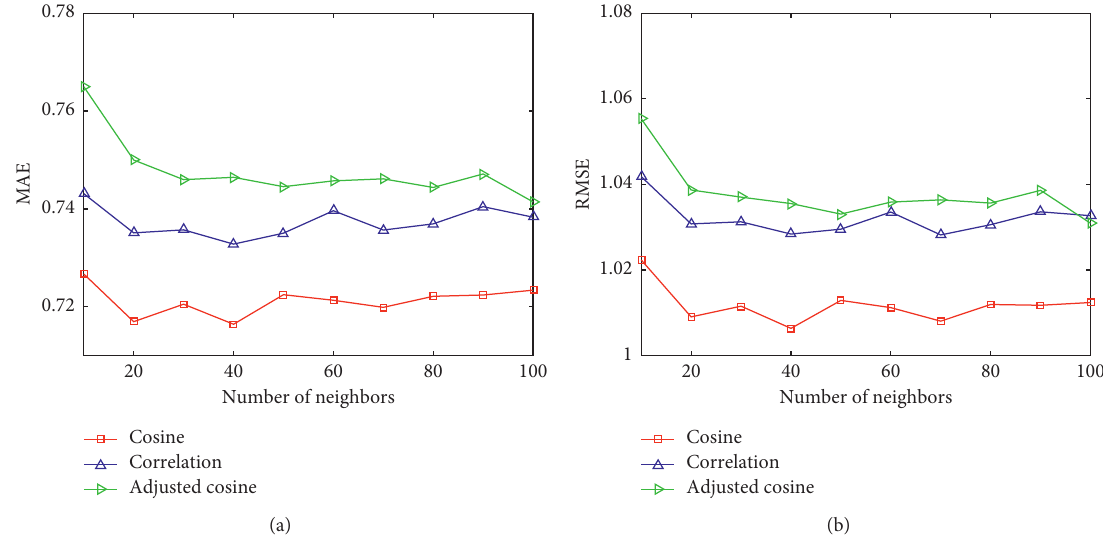
Figure 7: Movielens. (a) MAE results between three different similarities. (b) RMSE results between three different